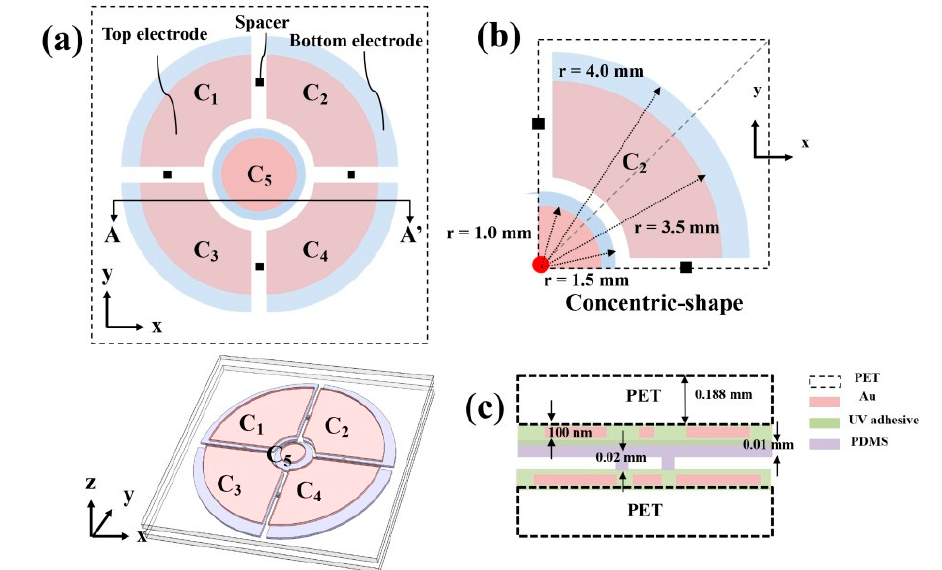
Figure 3. ( a ) Top view of the sensing unit which contained five capacitors; ( b ) Enlarged view of C2 in ( a ) with dimensions; ( c ) Cross-sectional of the sensing unit in ( a